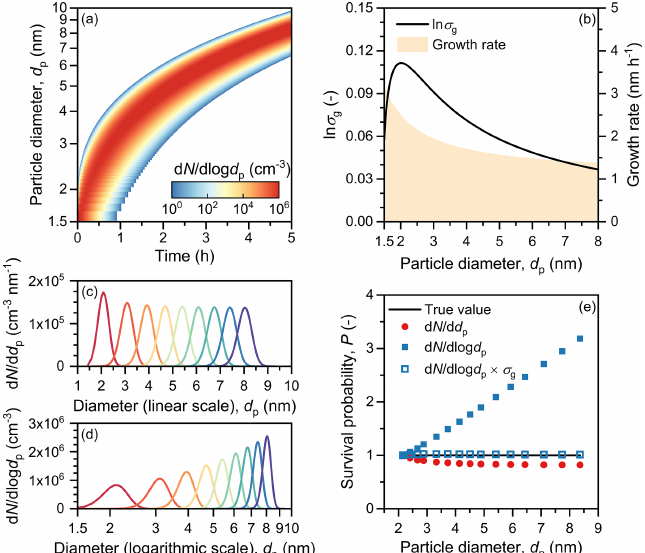
Figure A2. The growth of particles driven by the condensation of a non-volatile vapor. (a) Evolution of particle size distribution. (b) Geomet- ric standard deviation ( σ g ) and the growth rate of new particles. (c) Particle size distribution on the linear scale. (d) Particle size distribution in the logarithmic scale. (e) Survival probability of new particles computed using Eqs. (5)–(7). The results are simulated using a discrete model to avoid the influence of numerical diffusion. Particles are assumed to be strictly monodisperse ( σ g = 1 . 0). The coagulation between particles is not accounted for in this simulation. This figure shows that for particle growth driven only by the condensation of non-volatile vapors, d N/ d d p tends to stay at a relatively constant level, and σ g tends to decrease as particles grow. For such a case, the d N/ dlog d p method in Eq. (6) significantly overestimates the survival probability, and the d N/ dlog d p method with σ g correction in Eq. (7) should be used instead.